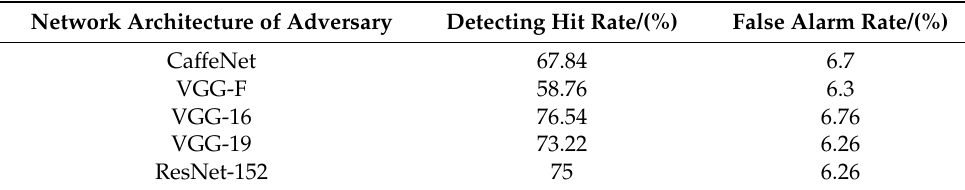
Table 4. Robustness of the TwinNet framework for defending GoogLeNet against a transfer attack on 10-class